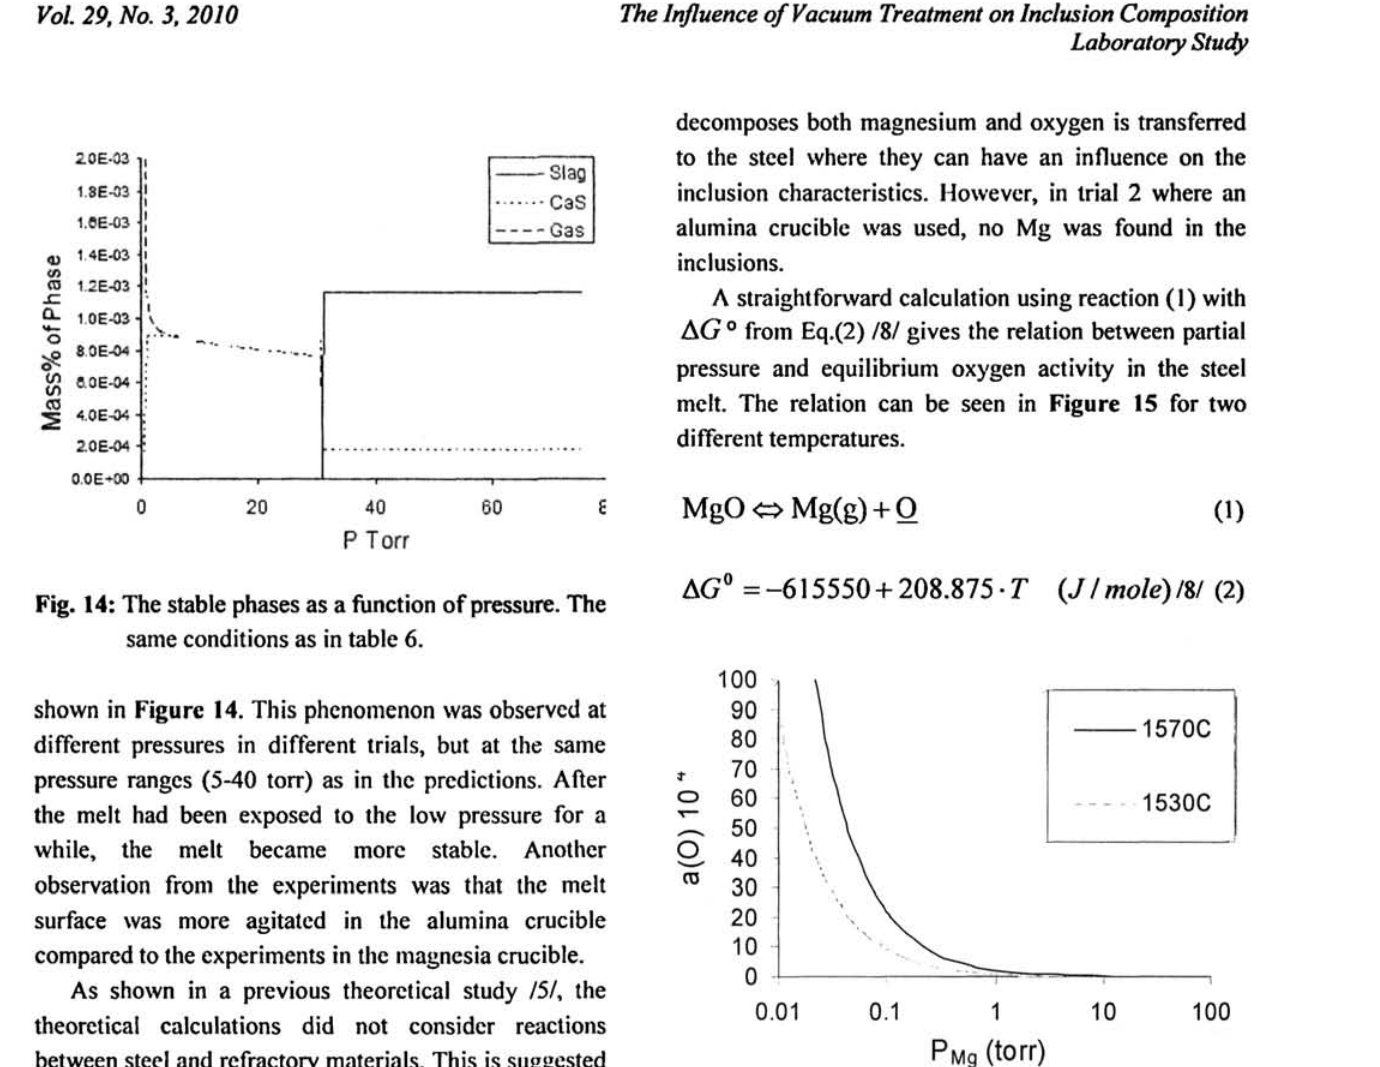
Fig. 15: Oxygen activity as a function of p